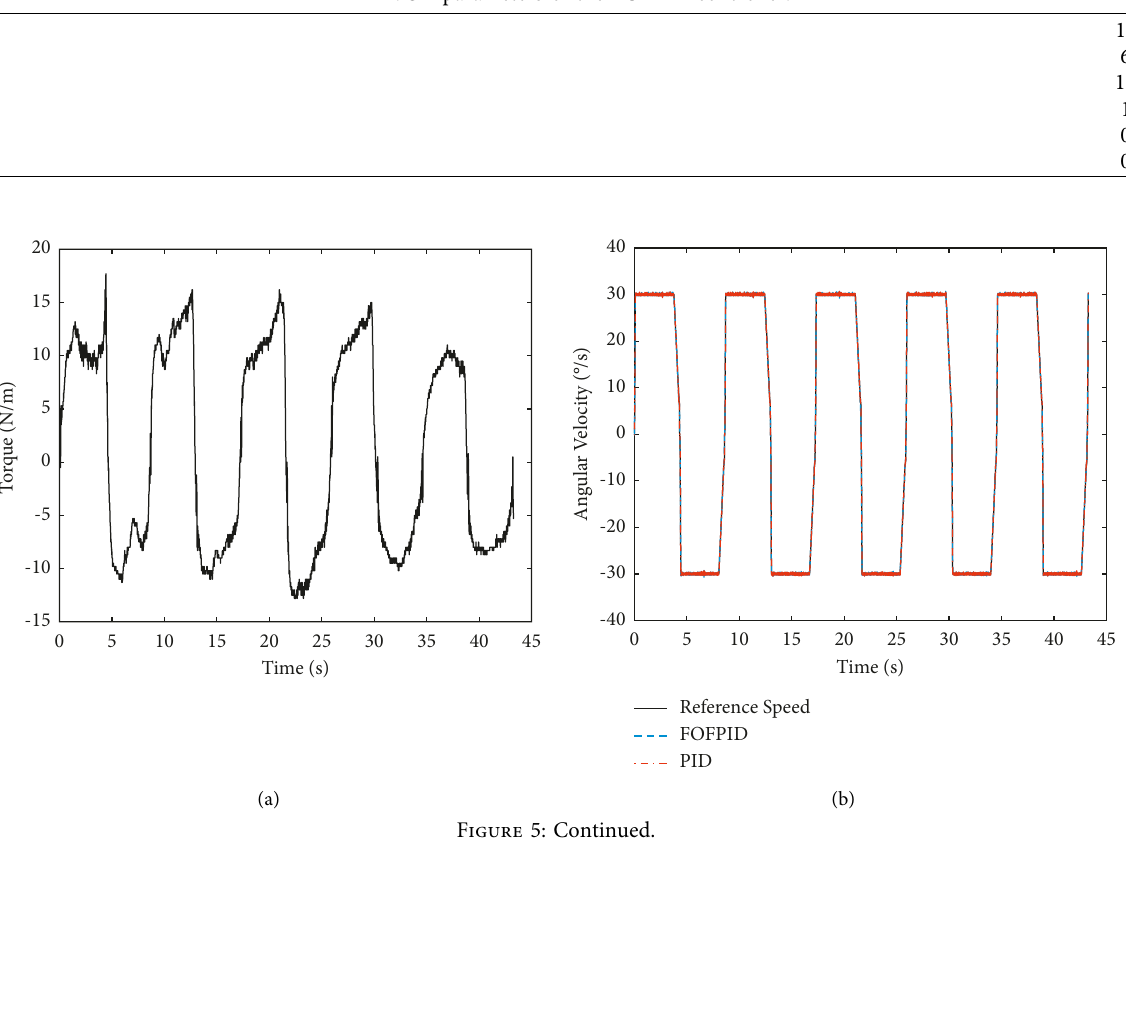
Figure 4: (a) Input membership functions. (b) Output membership functions. Table 1: Six parameters of the FOFPID controller.